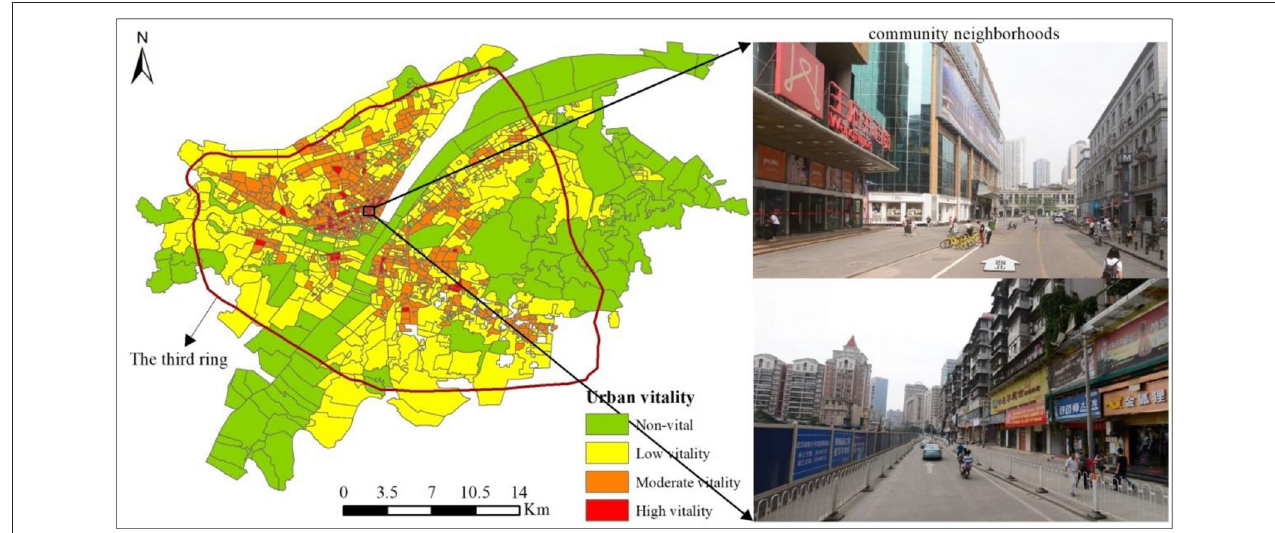
FIGURE 1 | The spatial distribution of urban vitality and community neighborhoods with the highest value of urban vitality (Red denotes high vitality; orange denotes moderate vitality; yellow denotes low vitality; and green denotes non-vital areas).